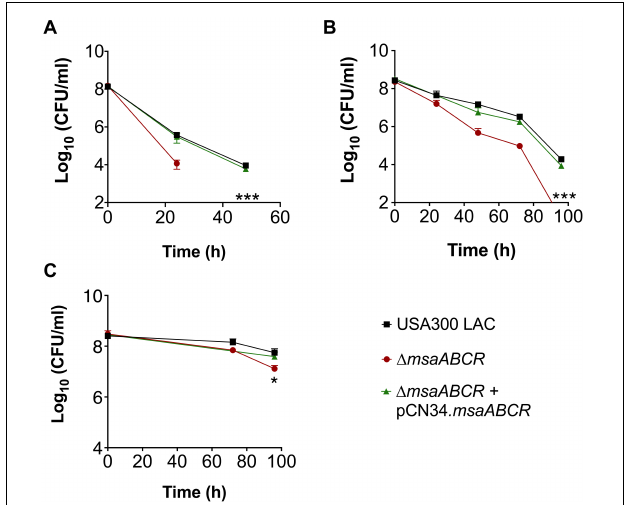
FIGURE 2 | Persister assay in late exponential growth phase. (A–C) The killing of USA300 LAC, (cid:77) msaABCR , and (cid:77) msaABCR + pCN34. msaABCR cells in the presence of antibiotics at the indicated times. All strains were grown in TSB to late exponential growth phase (OD 600 of 4.0) and exposed to gentamicin (20 × MIC), vancomycin (100 × MIC), or ciprofloxacin (100 × MIC). (A) Gentamicin treatment. (B) Vancomycin treatment. (C) Ciprofloxacin treatment. Error bars represent the standard error of the mean (SEM) from three independent experiments. Statistical significance was determined using ANOVA followed by Tukey’s multiple comparison tests. *, P < 0.05; ***, P < 0.0005.